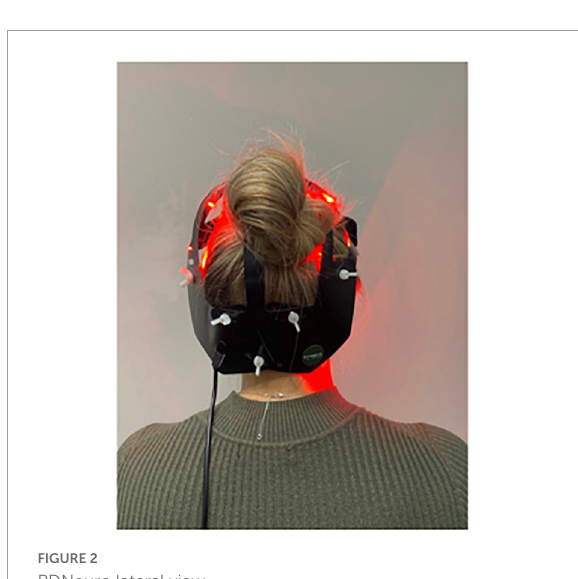
FIGURE1 PDNeuro posterior view.